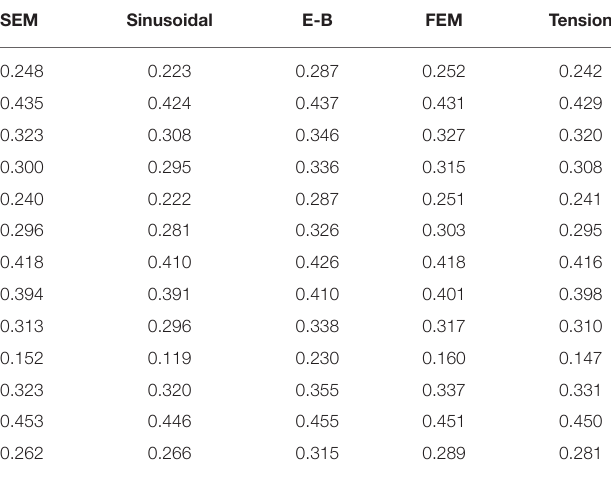
TABLE 3 | Position values for 15 µ m beam.